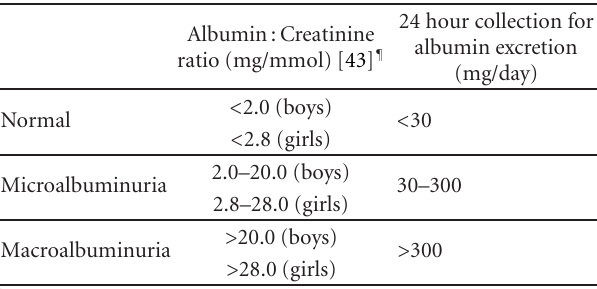
Table 1: Definitions for albuminuria ∗